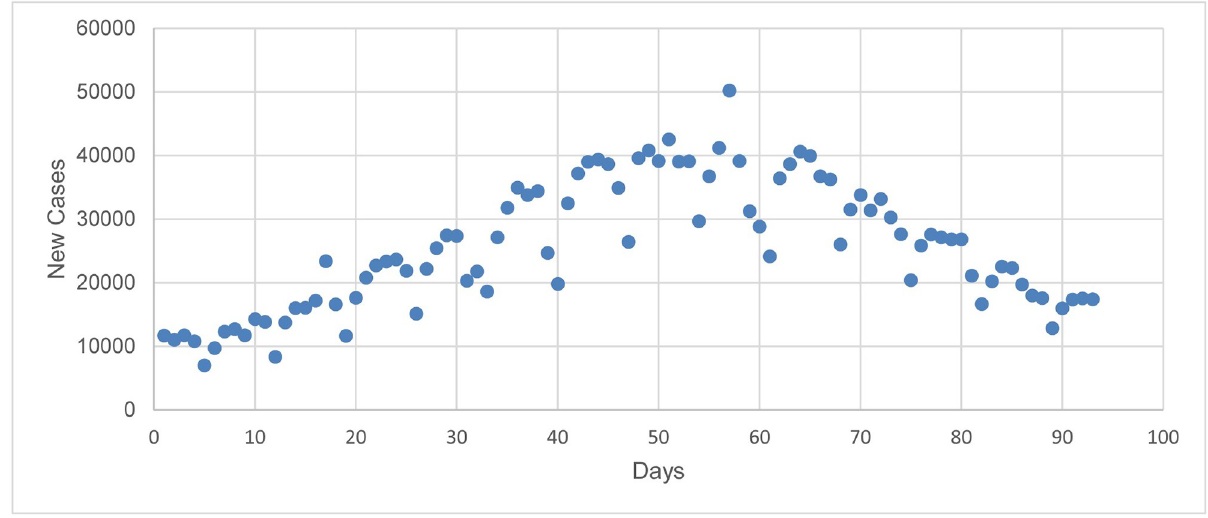
Fig 2. The number of daily infections for Delta variant in